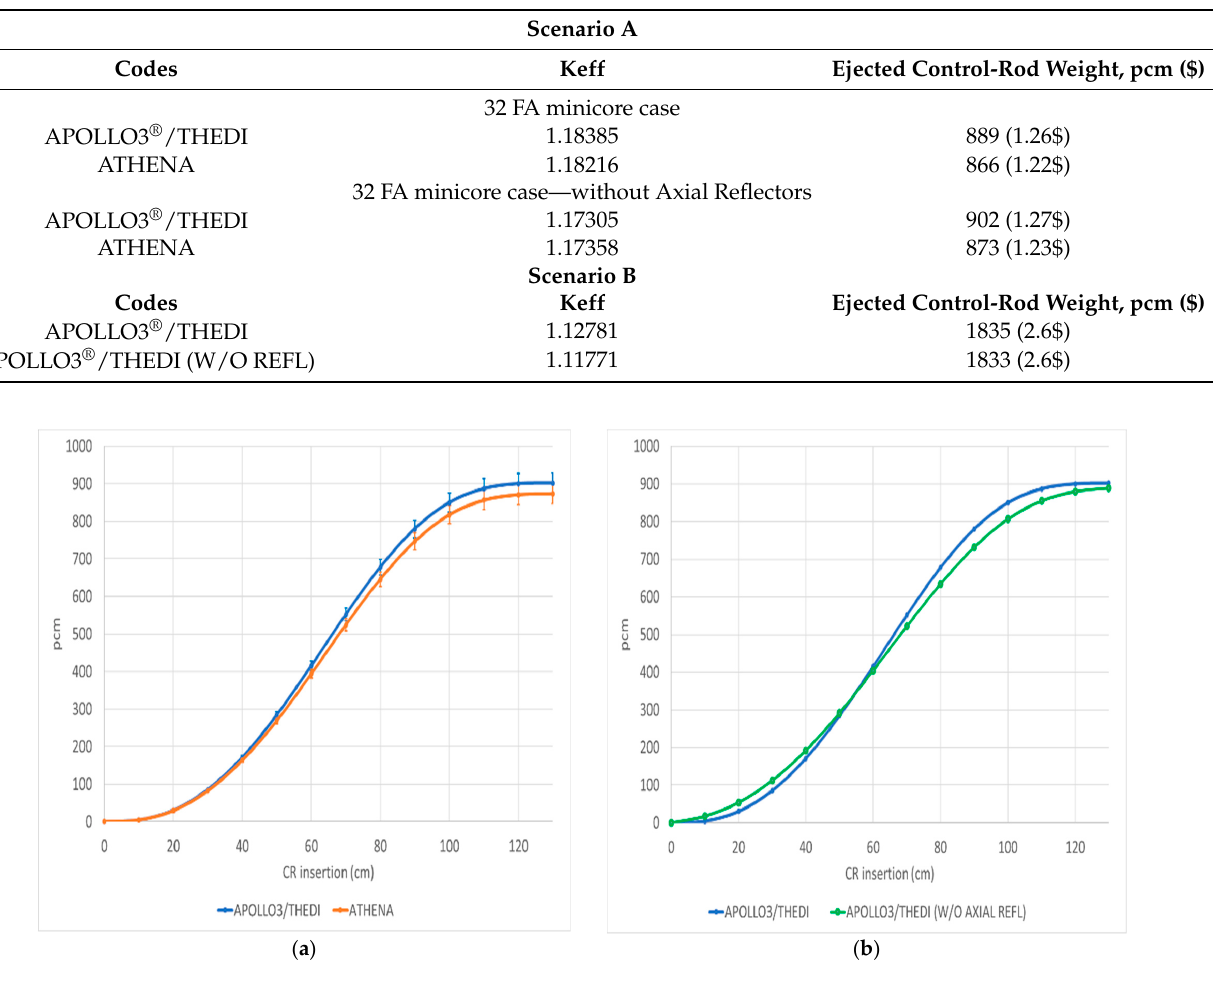
Table 8. Main results on the initial steady-state for Scenario A and Scenario B.